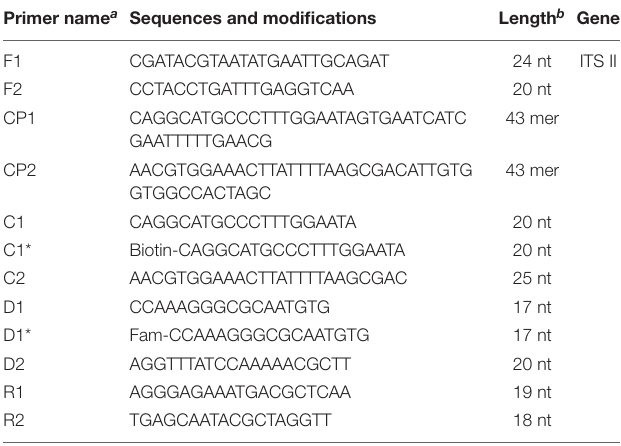
optimizing the isothermal amplification time during the reaction stage, four different times (10–40 min, with 10 min interval) were compared under the same reaction conditions, and all of the amplified products at each time point including 10, 20, 30, and 40 min were detected by MG and LFB, and each reaction was repeated three